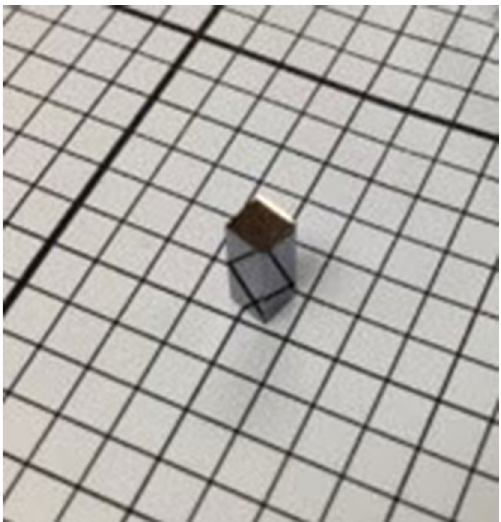
Figure 1. Optical photograph of the VFG detector sample with a gold contact on each end face. The sample dimensions are 3.5 × 3.5 × 9.15 mm 3 . The ruler on the same graph paper is displayed in the inset of Fig.